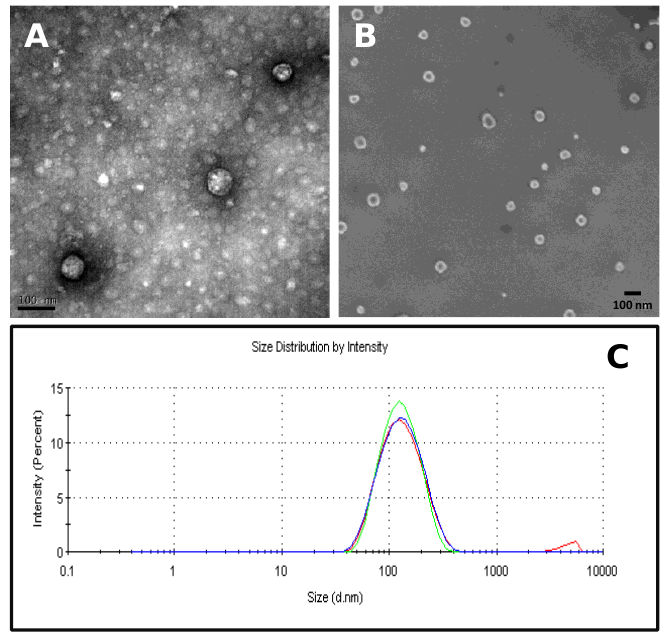
Figure 6. Physico-chemical characterization of purified vault-based nanoparticles. ( A , B ) show trans- mission and scanning electron microscopy images of purified vault-based nanoparticles, respectively. In both cases, bars (in black) correspond to 100 nm. In ( C ), nanoparticles size is estimated (triplicate readings shown) by dynamic light scattering analysis, showing a main peak at approx. 130 nm.